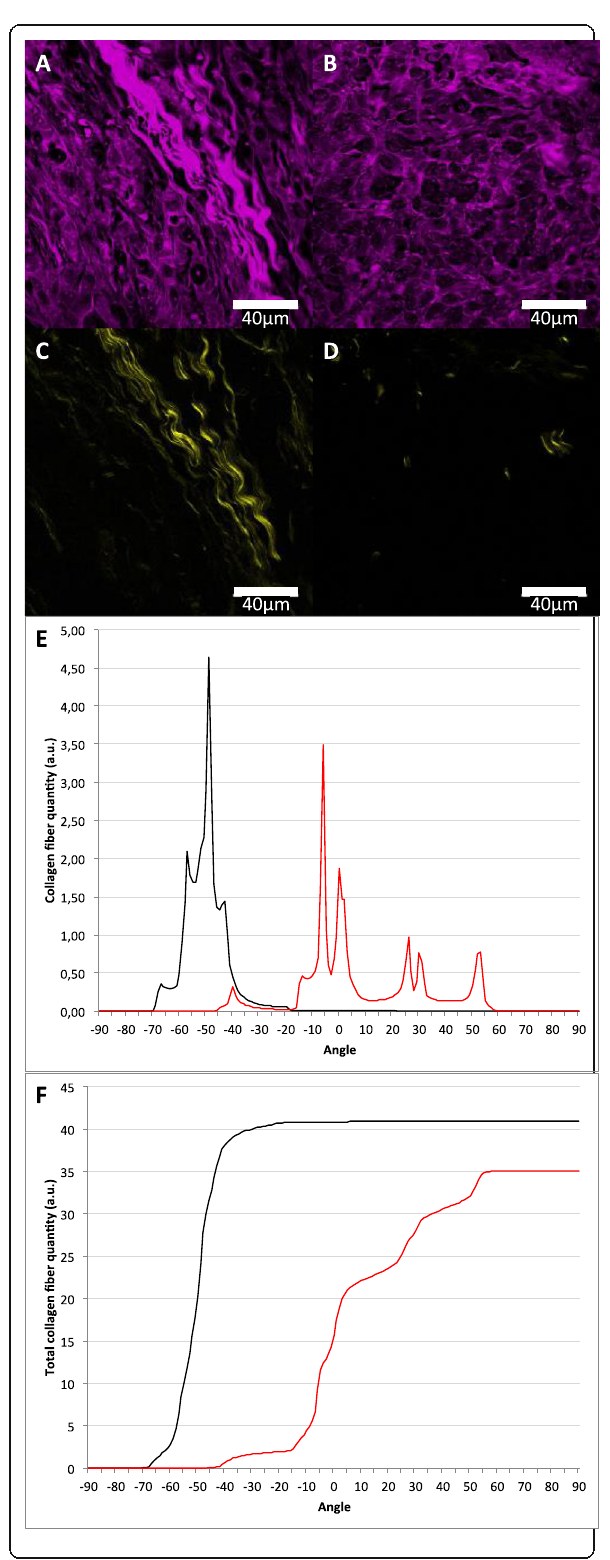
Fig. 4 Two cases of invasive ductal carcinoma of the breast. Images a and c show, respectively, two-photon-excited fluorescence microscopy (TPEF) and second harmonic generation (SHG) of a patient (P1) who presented disease progression (metastasis/ recurrence). b and d show, respectively, TPEF and SHG of a patient (P2) whose disease did not progress. In graphs E and F, the black line corresponds to patient P1 and the red line to patient P2. Notice that in graph e collagen fibers are arranged between − 70° to − 20° (variation of 50°) for patient P1 and between − 50° to 60° (variation of 110°) for patient P2. In graph f it is shown that patient P1 had total amount of collagen fibers greater than patient P2. This is in line with previous evidence that intratumoral collagen with less angulation, that is, more organized, and that greater amounts of intratumoral collagen are associated with higher risk